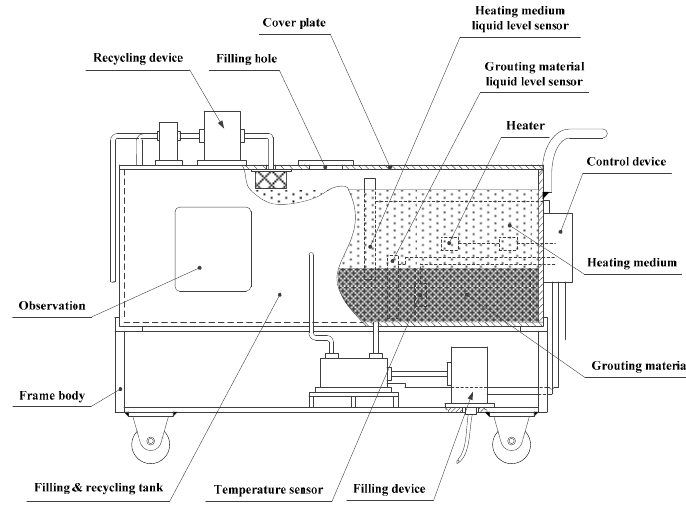
Figure 5. Grouting material preparation subsystem.